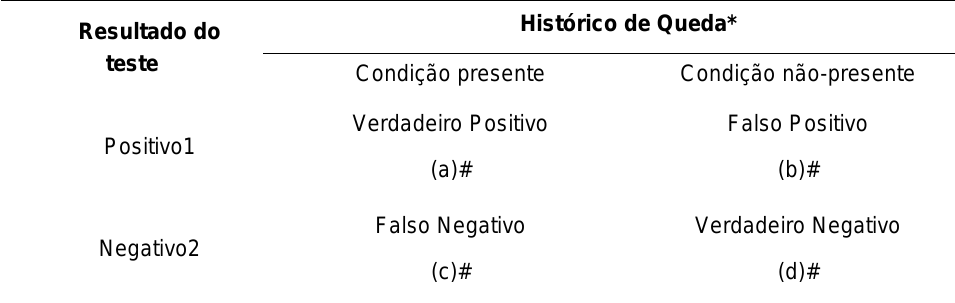
Tabela 1. Matriz 2x2, definição dos índices de